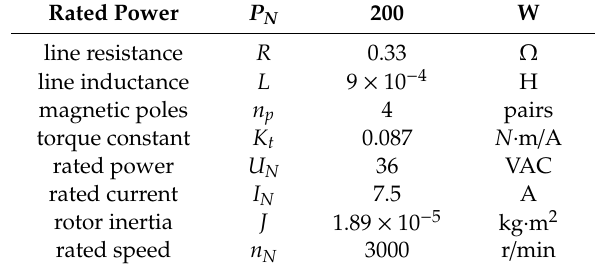
Table 1. Rated parameters of the permanent magnet synchronous motor (PMSM).